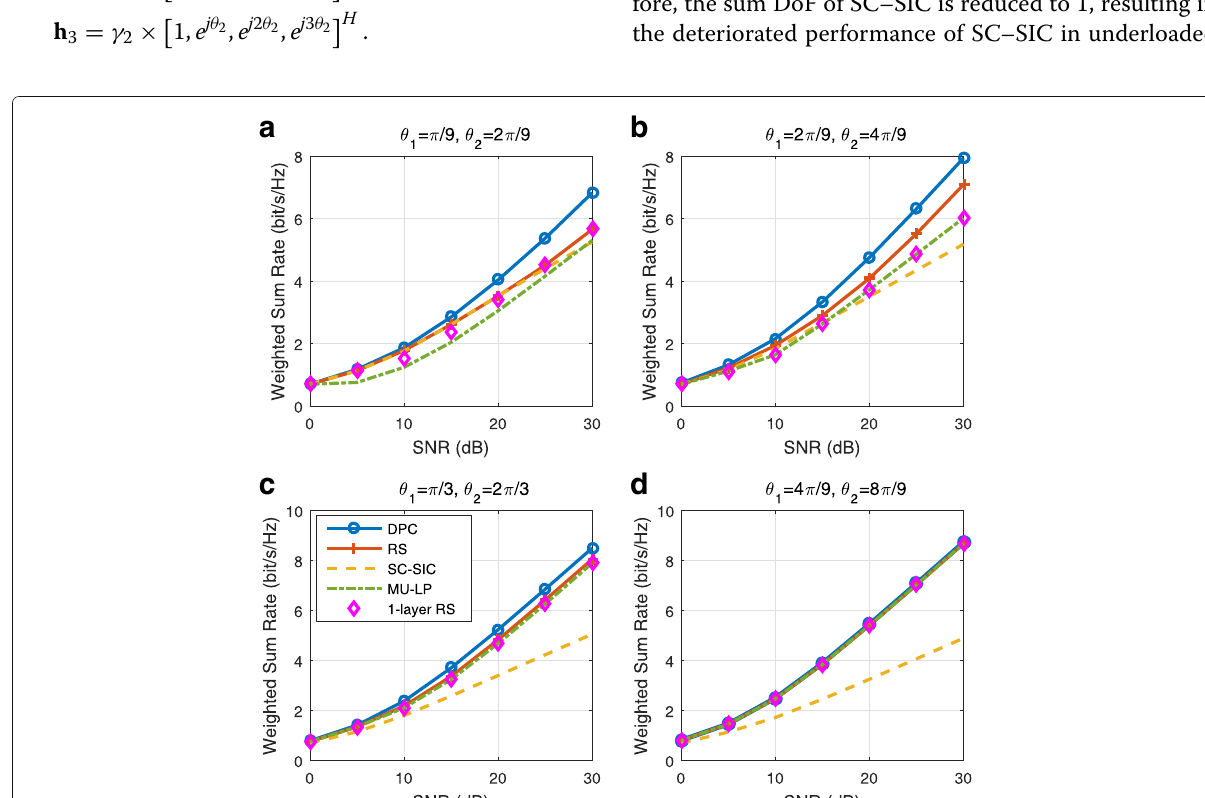
Fig.13 Weighted sum rate versus SNR comparison of different strategies for underloaded three-user deployment with perfect CSIT, γ 1 = 1, γ 2 =